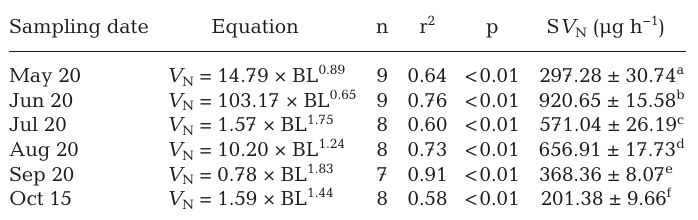
Table 5. Allometric relationship between phosphorus excretion rate ( V P ; µg h −1 ) and body length (BL; cm), and corresponding standardized